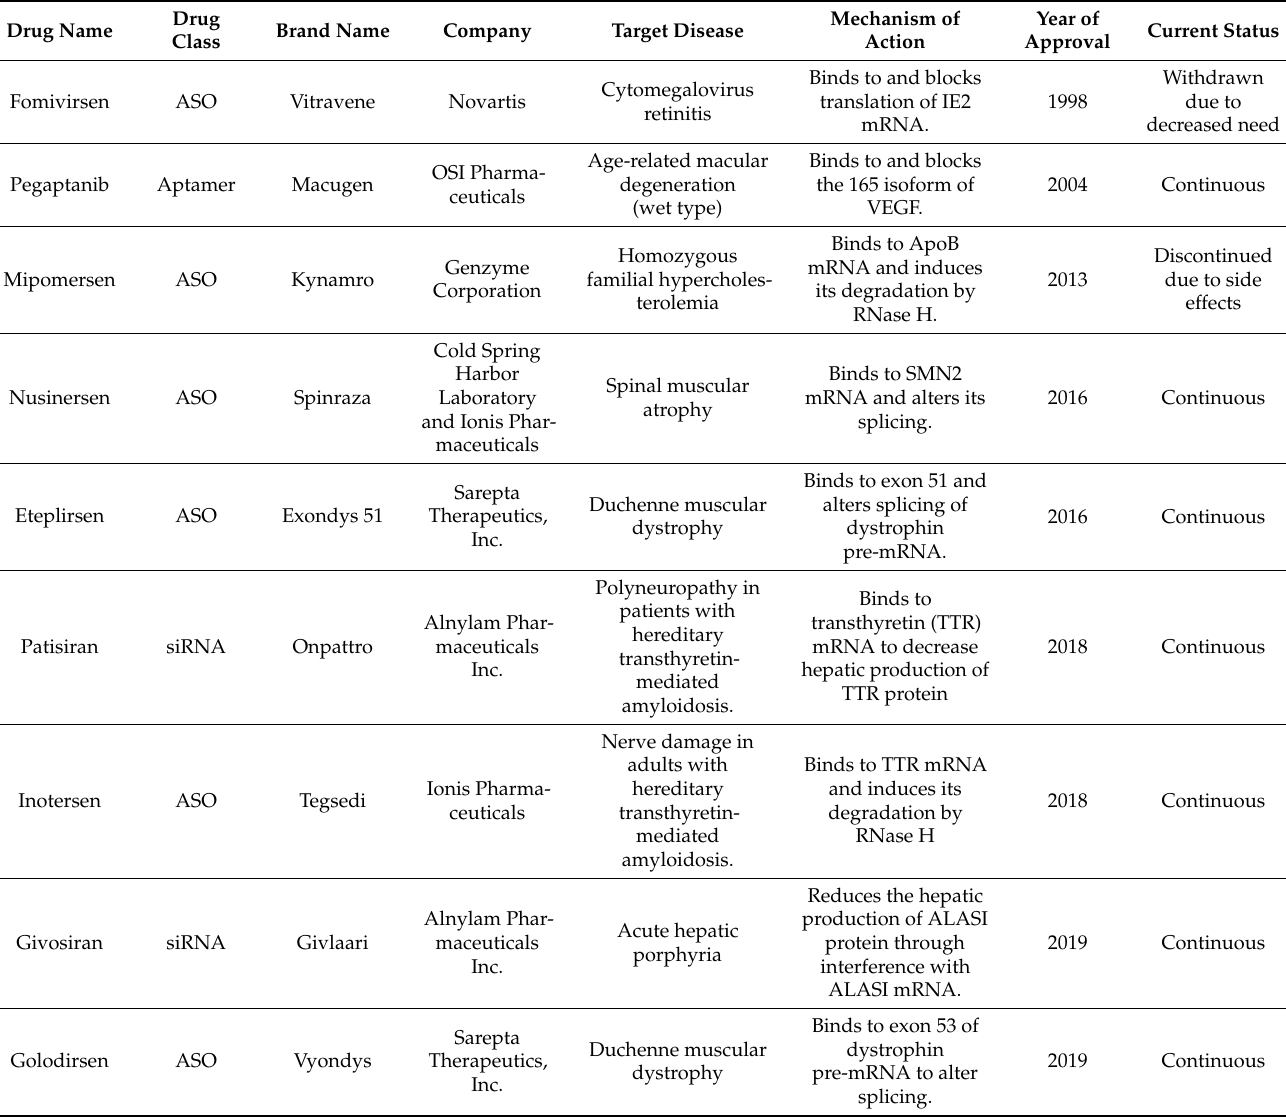
Table 1. FDA-approved RNA therapeutics for the treatment of human diseases in chronological order, adapted from